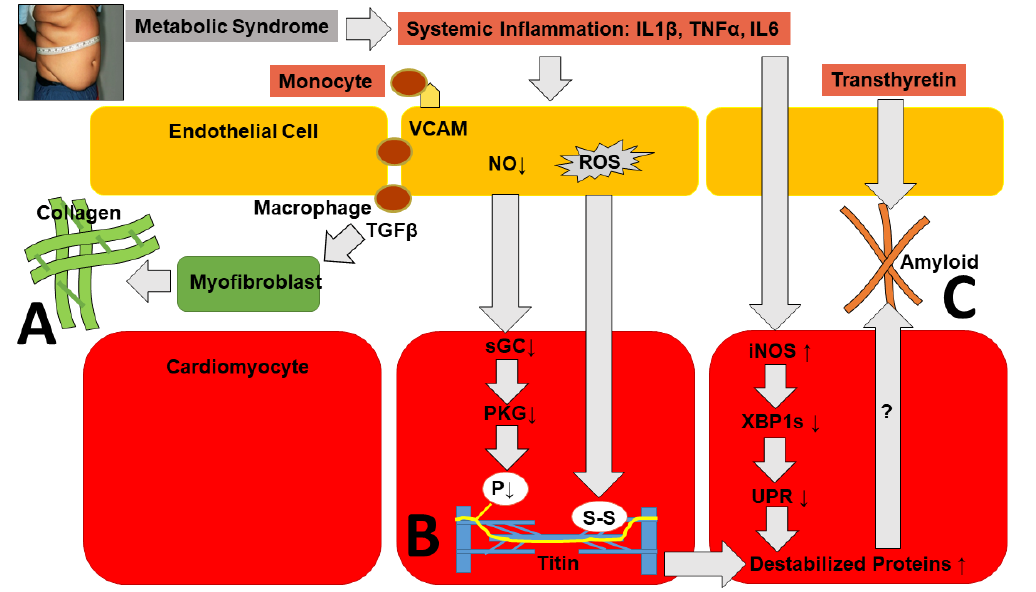
Figure 5. Pathophysiological mechanisms linking systemic inflammation to diastolic LV stiffness. ( A ): Systemic inflammation causes the endothelial expression of adhesion molecules (VCAM: vascular cell adhesion molecule). They attract monocytes that become macrophages secreting transforming growth factor β (TGF β), which stimulates myofibroblasts to deposit collagen. ( B ): Systemic inflammation lowers the endothelial production of nitric oxide (NO), soluble guanylate cyclase (sGC) activity, protein kinase G (PKG) activity, and titin phosphorylation (P). Systemic inflammation also causes the endothelial production of reactive oxygen species (ROS) with the formation of disulfide bonds (S-S) within titin. Both hypophosphorylation and S-S bonds increase titin stiffness. ( C ): Systemic inflammation boosts the expression of inducible NO synthase (iNOS). This lowers X-box binding protein 1 spliced (XBP1s) and the activation of UPR genes, which can potentially lead to the accumulation of destabilized proteins similar to transthyretin-induced amyloid deposits.